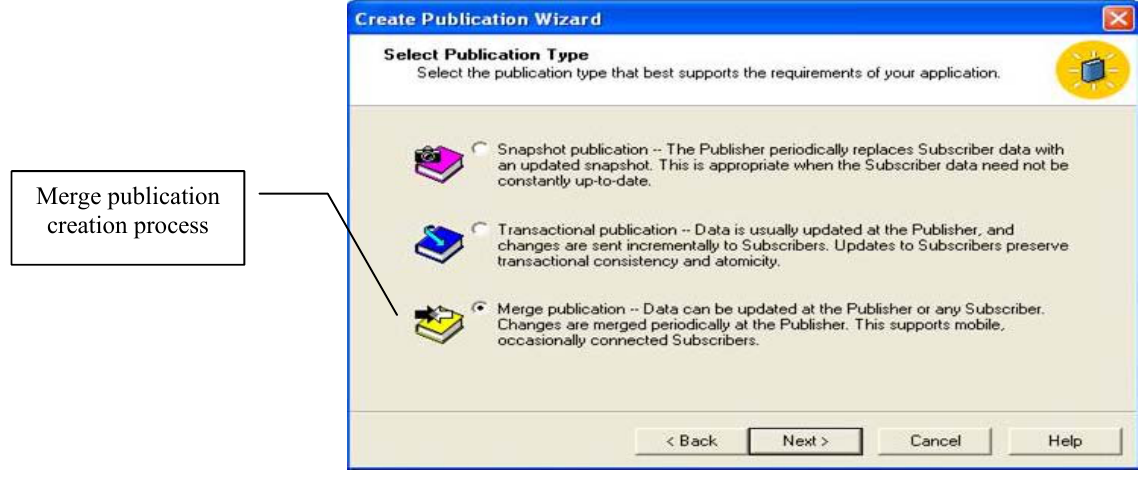
Figure 5: Publication creation process